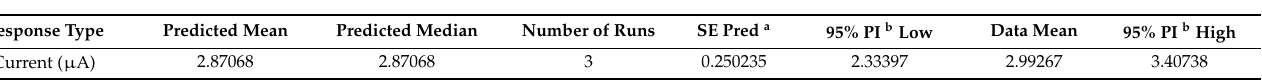
Table 4. Model confirmation